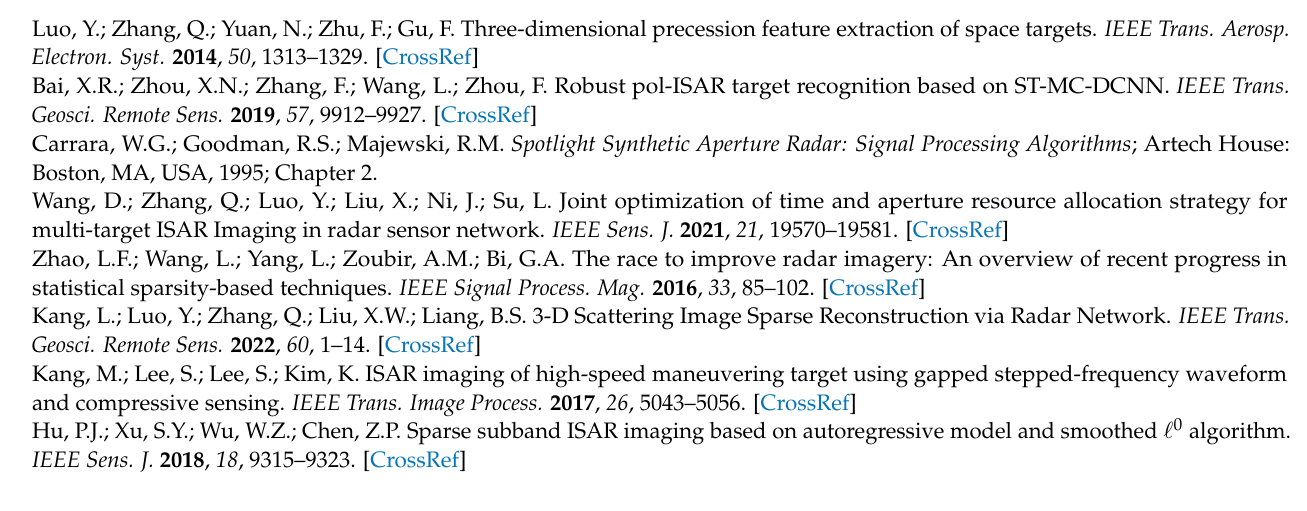
Figure 12. Variation of ( a ) NMSE, ( b ) PSNR, and ( c ) SSIM with the number of layers for DnCNN.